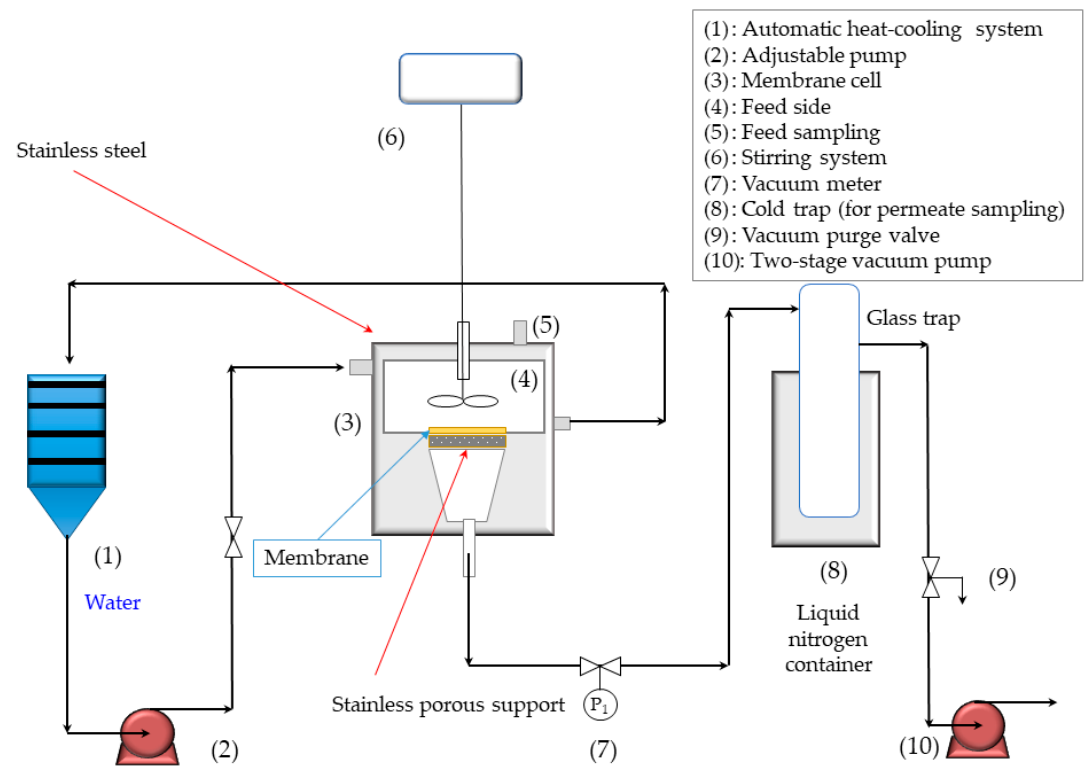
Figure 1. Graphical depiction of the experimental set-up used in PV experiments.